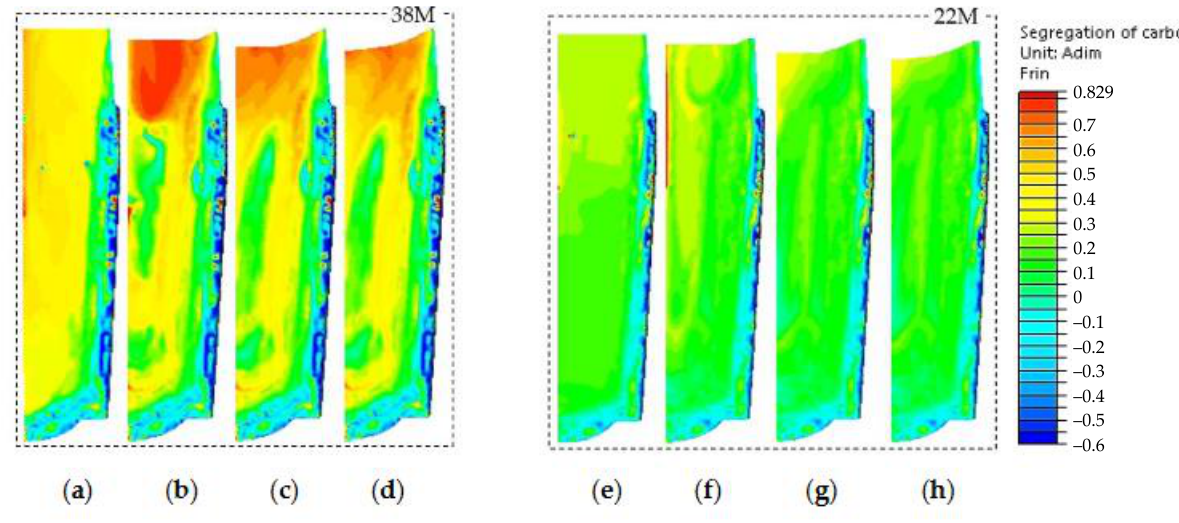
Figure 3. Predicted macrosegregation ratio patterns of carbon in the solidification process at times of: ( a , e ) 1.5 h; ( b , f ) 5.5 h; ( c , g ) 10.5 h; ( d , h ) end of solidification.